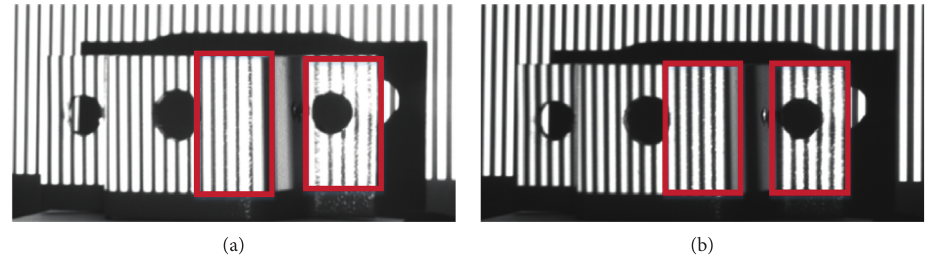
Figure 8: Contrast result of the fringe projection effect: (a) conventional method; (b) our method.